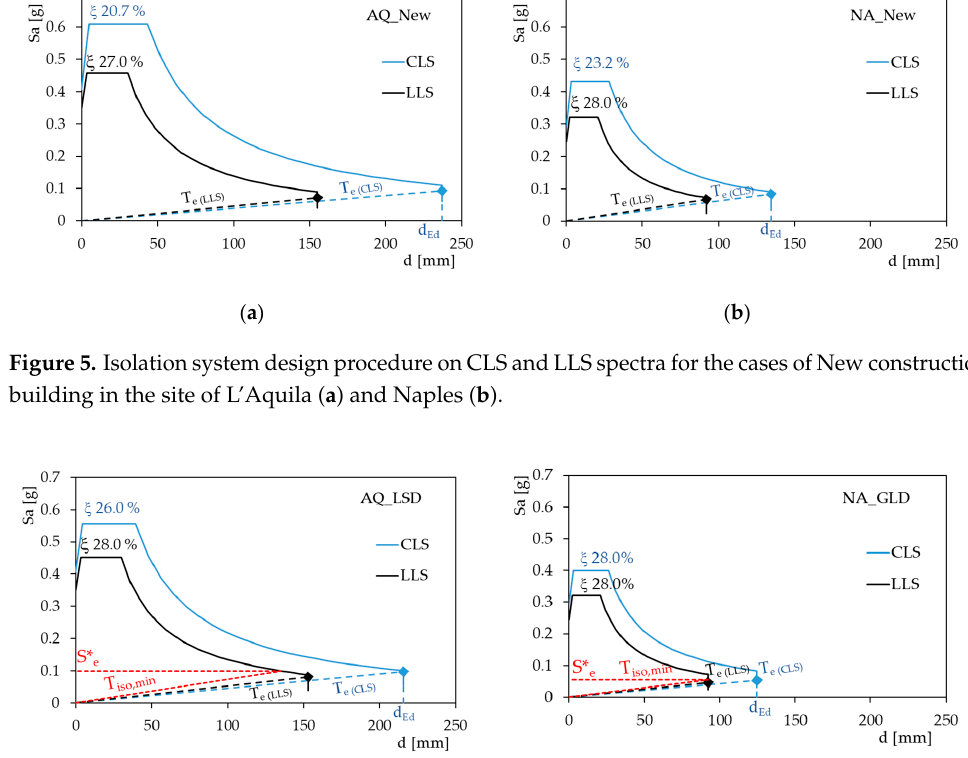
The characteristics of designed DCCSS bearings for all case studies are reported in Table 3. The maximum displacement d (cid:2923)(cid:2911)(cid:2934) has been assumed by catalogue, taking into account torsional effects.